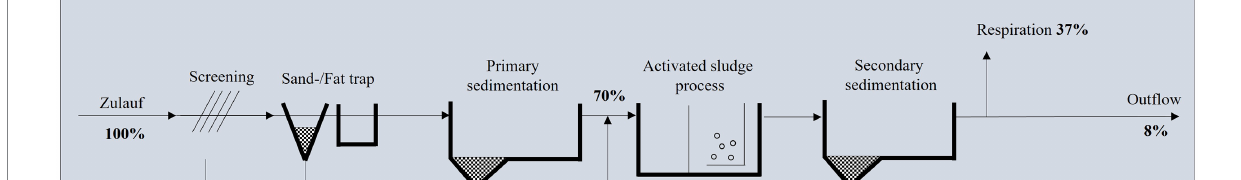
activated filter after the secondary